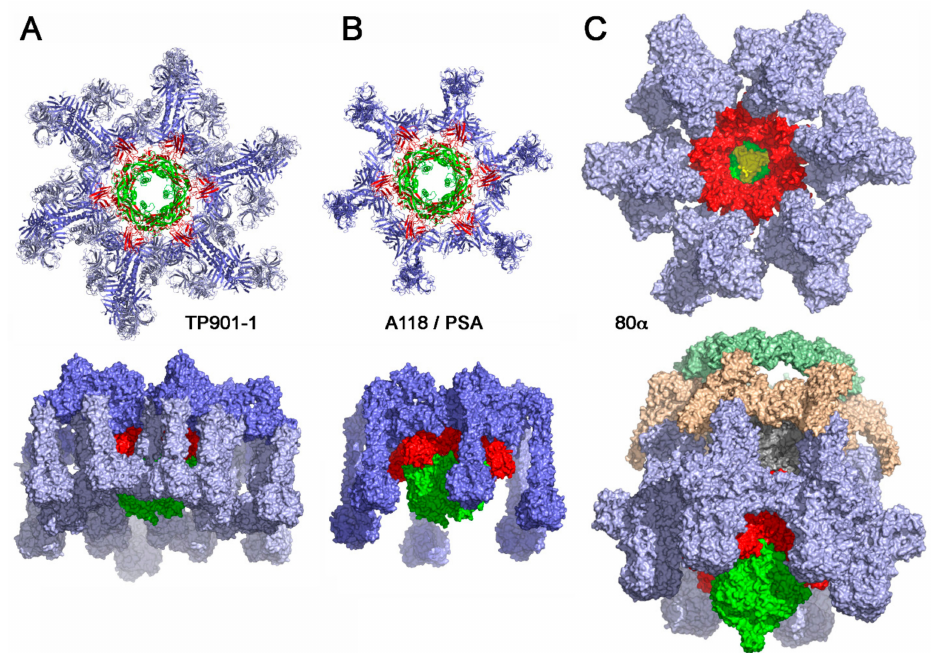
Figure 5. Structures of binding-ready baseplates from siphophages binding to a host cell wall saccharidic receptor. ( A ) X-ray structure of the baseplate from phage TP901-1; the Tal trimer has been modeled by addition of phage p2 Tal to the X-ray structure. ( B ) Model structure of the RBP from phages PSA or A118. ( C ) -cryoEM structure of phage 80 α baseplate [15]. The color-coding is identical to that in Figure 2: Dit: red; tal: green: RBP: pale blue; ancillary proteins dark blue; in ( C ) Fiber proteins are colored beige and pale green (80 α